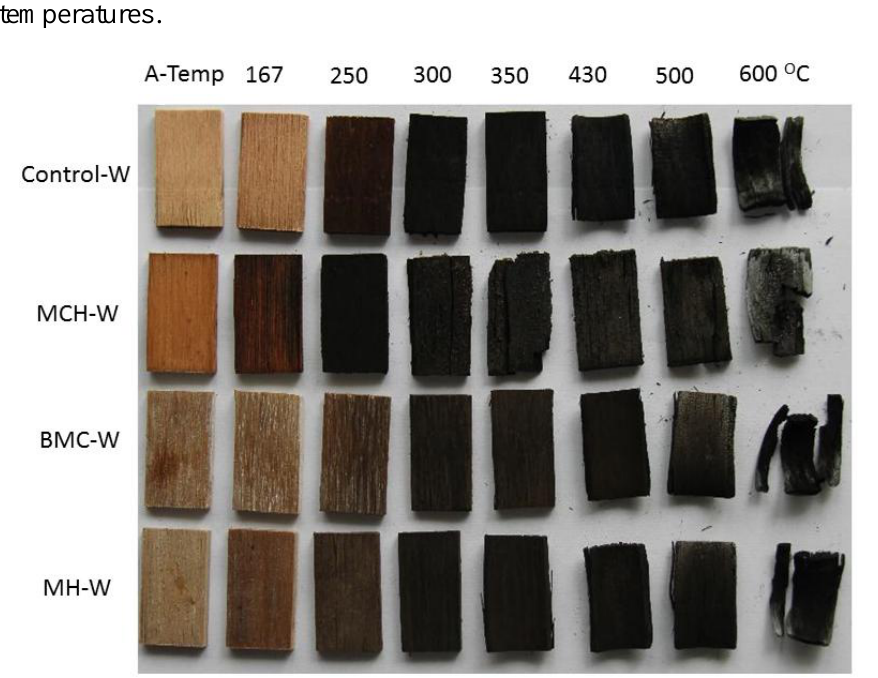
Figure 2. Photographs of untreated and fire-retardant treated red gum wood calcined at different